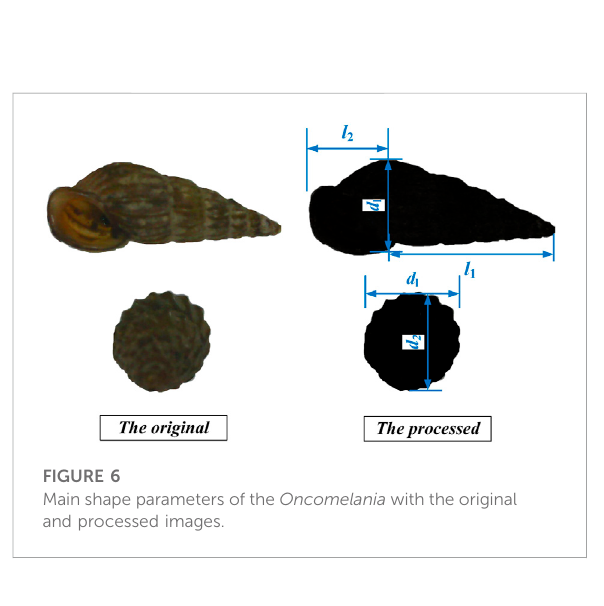
FIGURE 7 The linear relationship between A pm and parameter (0.5 π l 2 + l 1 ) d 1